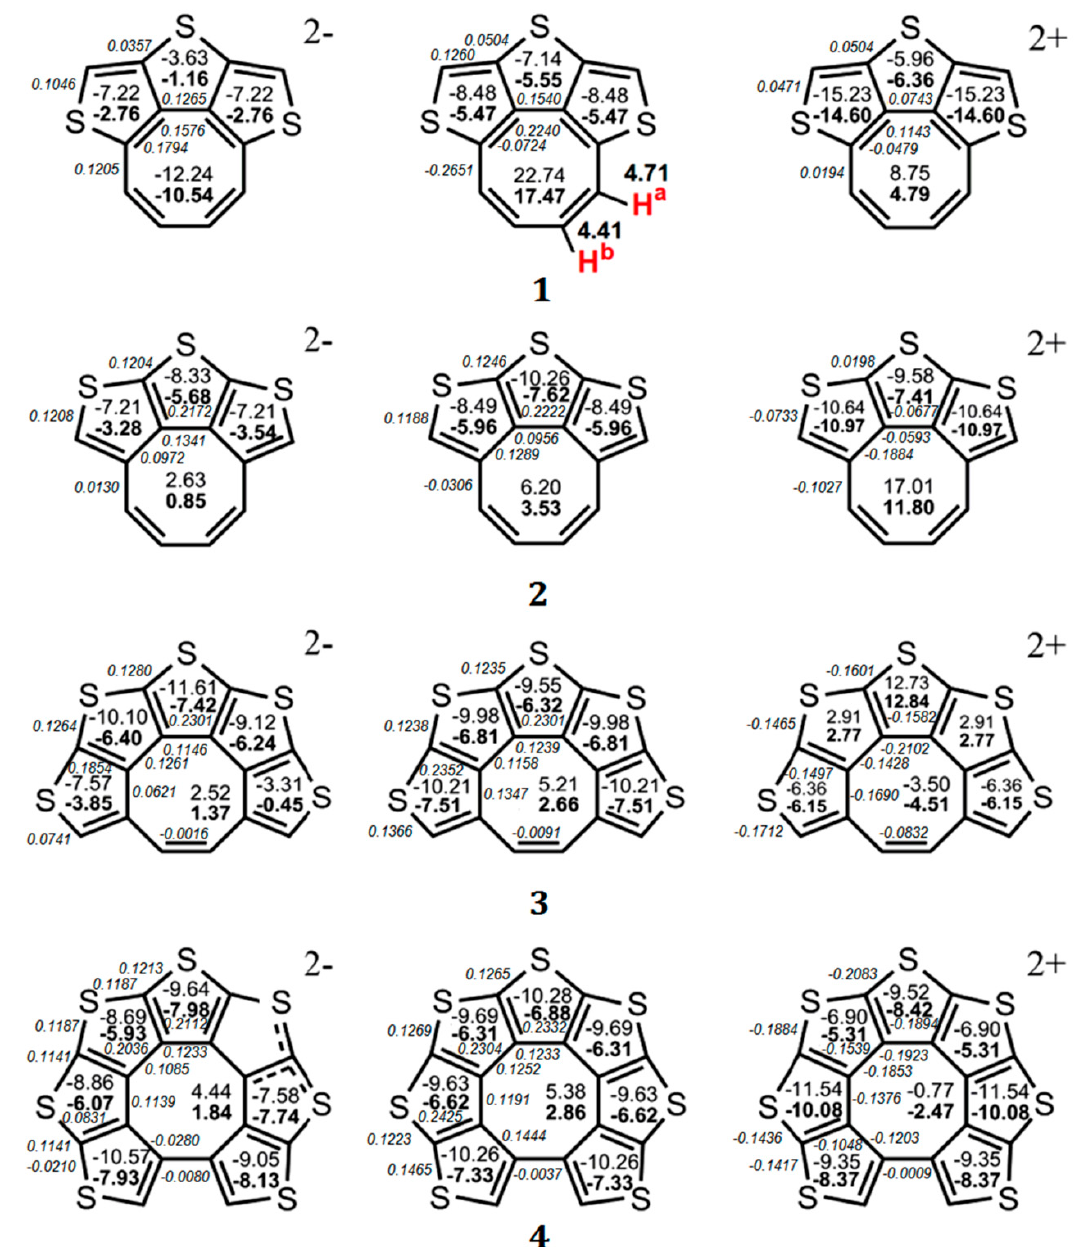
Figure 2. The values of NICS(0) (top number) and NICS(1) (bottom number indicated in bold) indices calculated at the GIAO/B3LYP/6-311++G(d,p) level of the theory for the neutral molecules of quasicirculenes 1 – 4 and their corresponding dianions and dications [50] and experimental values of the 1 H NMR chemical shifts [52]. The BREs in units of | β | for the neutral and doubly charged ions of 1 – 4 were taken from Ref. [51] and are presented in italics.